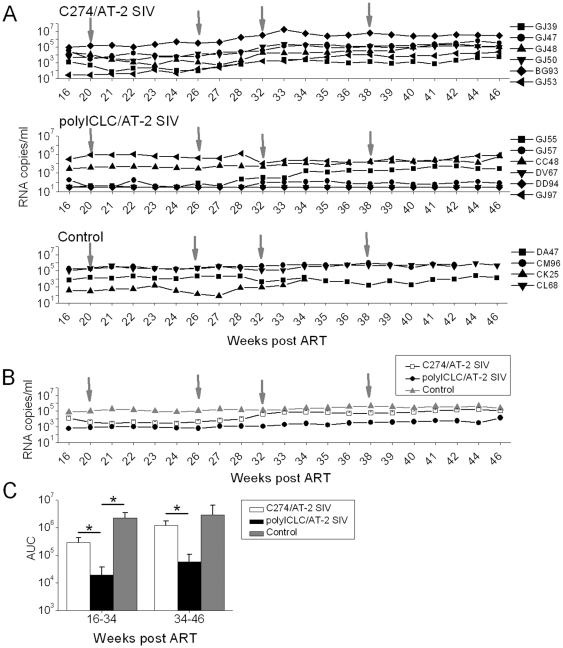
Viral loads are not impacted by late immunization with polyICLC/AT-2 SIV without ART.(A) Plasma viral loads were determined before, during and after treatment. Each symbol indicates an individual animal. Arrows indicate immunization time-point. (B) The average viremia (geometric means) for each group (±SEM) is shown. Asterisks denote the statistically significantly lower virus levels in the polyICLC group compared to the original C274 and/or control groups; p<0.04 for polyICLC vs C274 at weeks 23–46, p<0.03 for polyICLC vs control at weeks 20–34, for good ART responders. (C) Average AUC is shown for each group (±SEM) for the time period shown in panel A. Asterisks mark the statistically significant differences: polyICLC vs C274 at weeks 16–34, p<0.03; polyICLC vs control at weeks 16–34, p<0.03; polyICLC vs C274 at weeks 34–46, p<0.05. Each group's original treatment under ART is indicated in each panel.